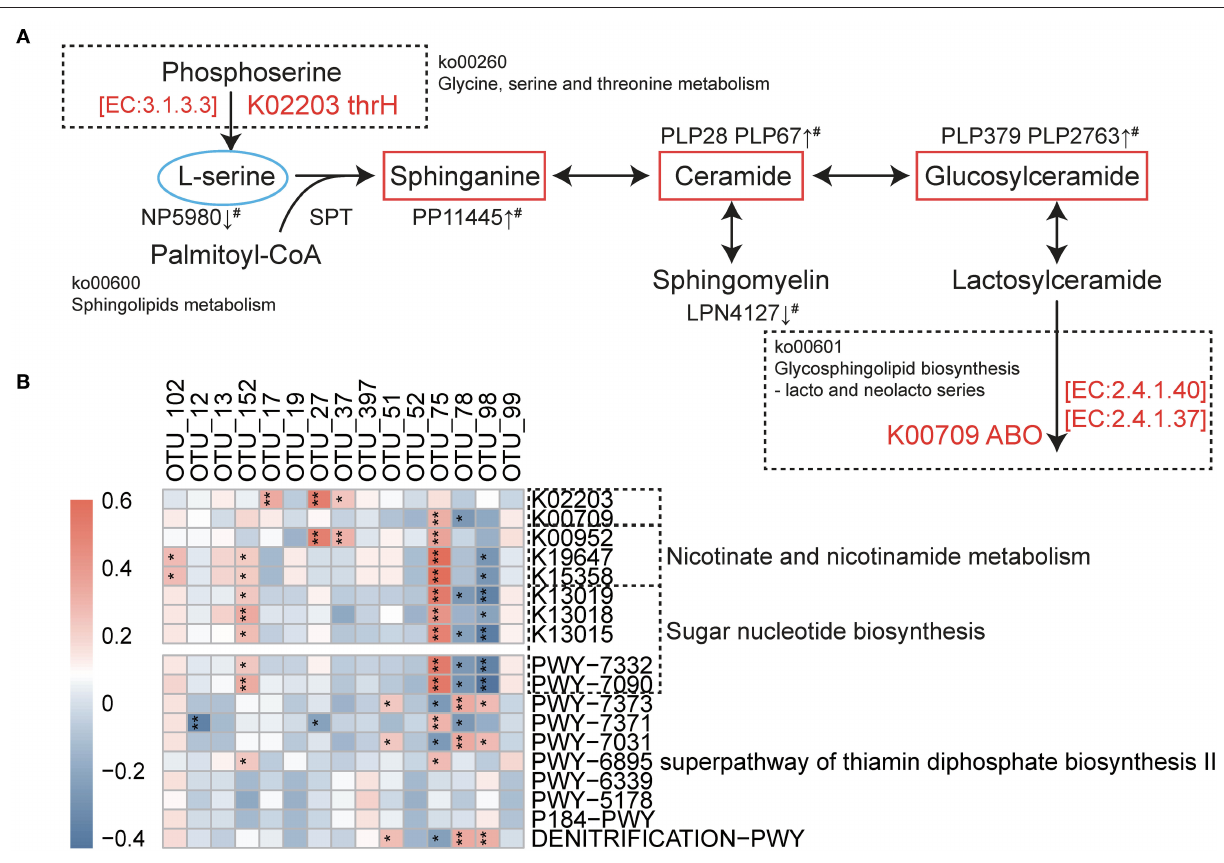
and histo-blood group ABO system transferase